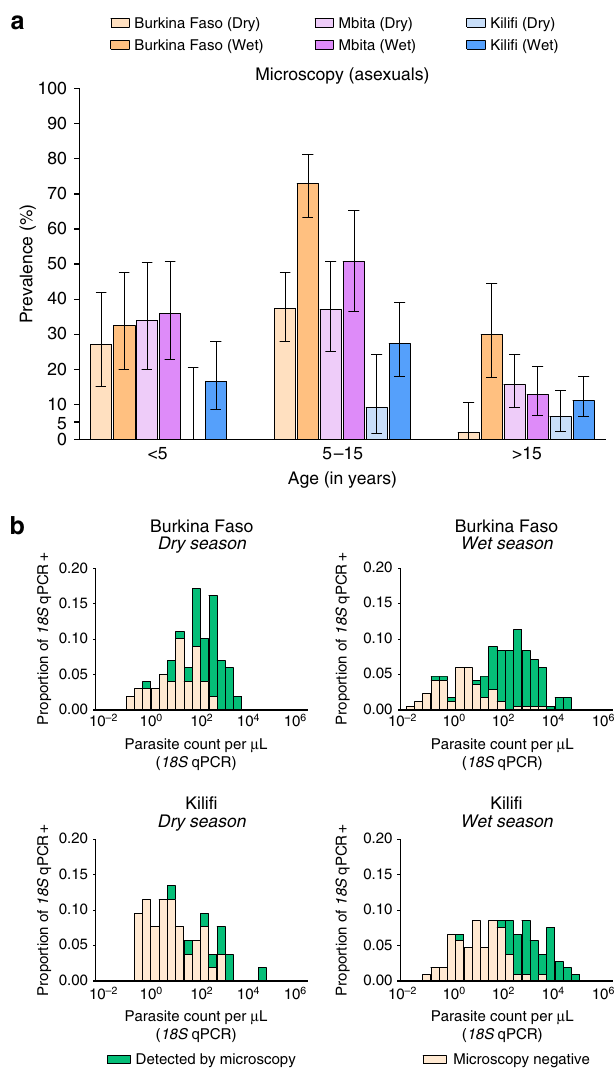
Fig. 1 Age-speci fi c asexual stage parasites prevalence by microscopy ( a ) and distributions of parasite densities ( b ) by study site. In a , 95% exact binomial con fi dence intervals are presented for microscopy-based parasite prevalence estimates. All participants, except three children in Laye and one in Balonghin, had microscopy results available; numbers of study subjects by age group and survey are presented in Table 1. In b , parasite densities quanti fi ed by DNA-based 18S qPCR are presented (log 10 scale) for both patent and subpatent infections. This panel only includes 18S qPCR- positive samples (100, 166, 52 and 105 in Burkina Faso dry and wet season surveys, and Kili fi dry and wet season surveys,